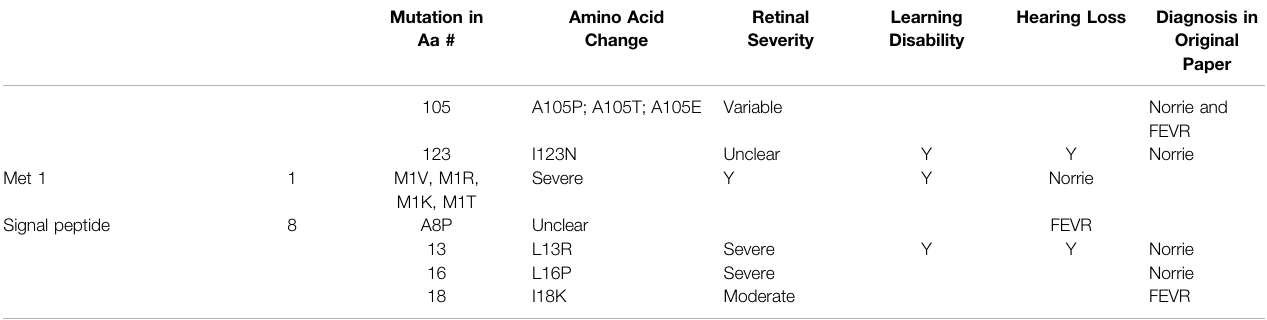
insertions/inversions/duplications and splice site variants invariably caused ‘ severe ’ retinopathy whilst UTR mutations only caused moderate retinopathy ( Figures 3 , 4 ).